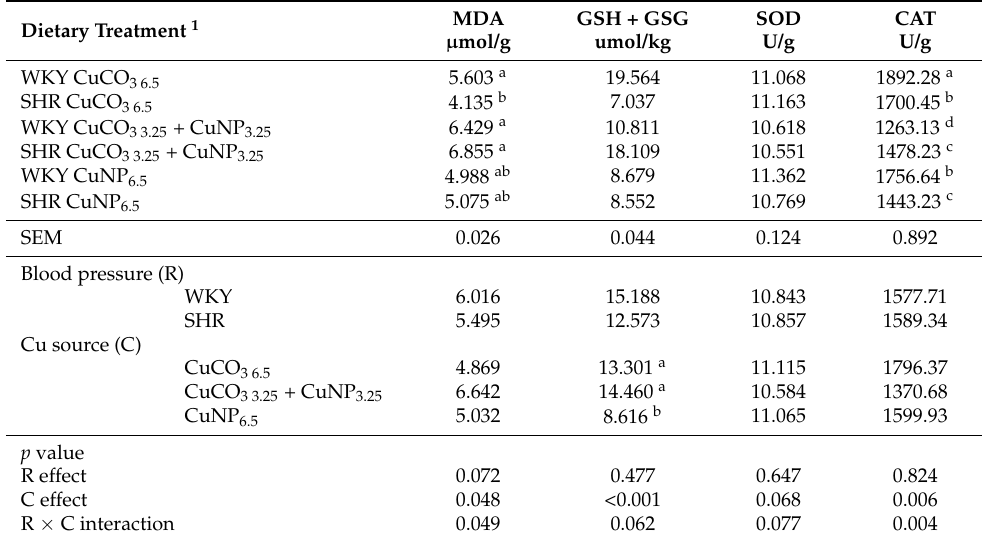
Table 5. Redox status in small intestinal